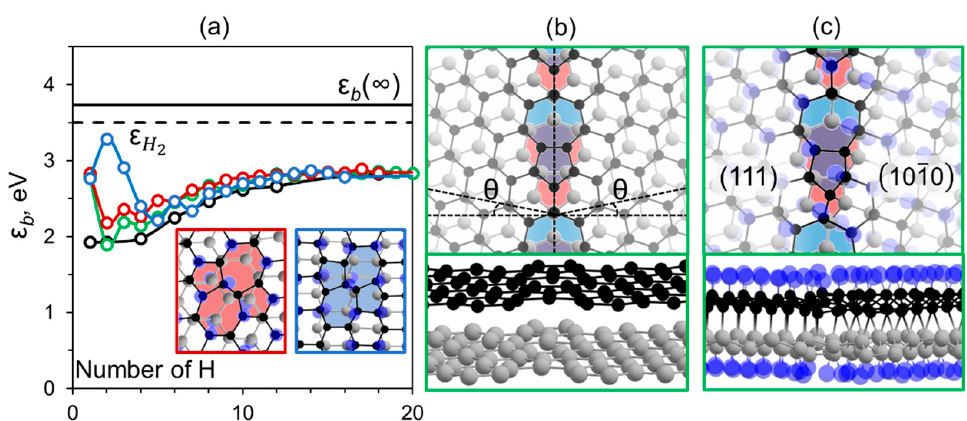
Figure 2. ( a ) Average binding energy per H for all clusters considered as a function of their size, n, for bilayer graphene containing SW defect in one layer with AB (red line), AA’ (blue line) stacking, as well as for polycrystalline bilayer graphene containing grain boundary (green line). In the inset the hydrogenated SW defect in cubic and hexagonal diamane are presented framed by the corresponding color. H bonding energies in the H 2 molecule ( ε H ) and in the infinite diamane ( ε b ( ∞ )) are marked by dashed and solid horizontal lines, respectively; ( b ) the atomic structure of polycrystalline bilayer graphene containing symmetrically inclined grains by θ = 11.5° with 5|7 defects highlighted by blue and red colors corresponding to first and second layer, respectively; ( c ) atomic structure of polycrystalline diamane produced by hydrogenation of graphene presented in ( b ) consisting of grains with cubic diamond and lonsdaleite structures.